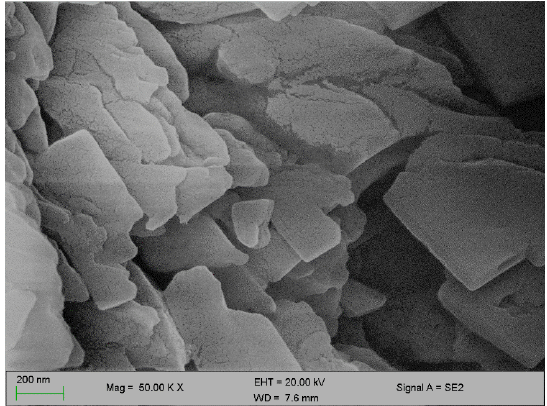
Figure 2. SEM surface morphology of the bioflocculant.